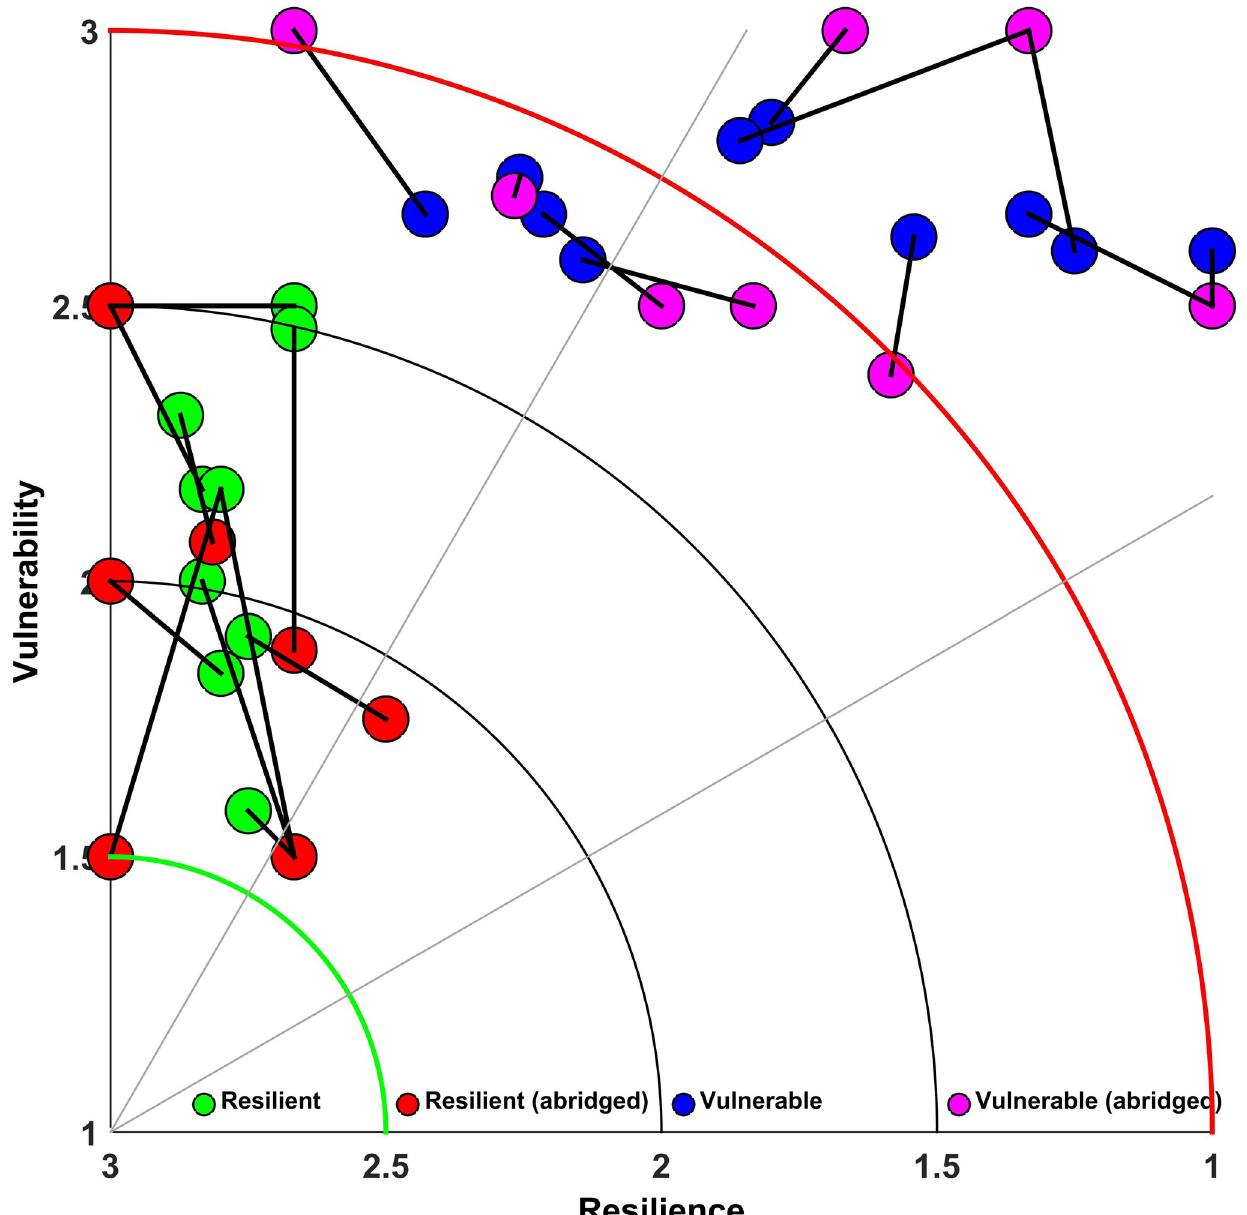
Fig 7. Scatter plot showing the relative change in Euclidean distance of 10 most resilient and vulnerable species by applying the abridged (6) attributes. Lines between points indicate the distance and angle of change from the original score.